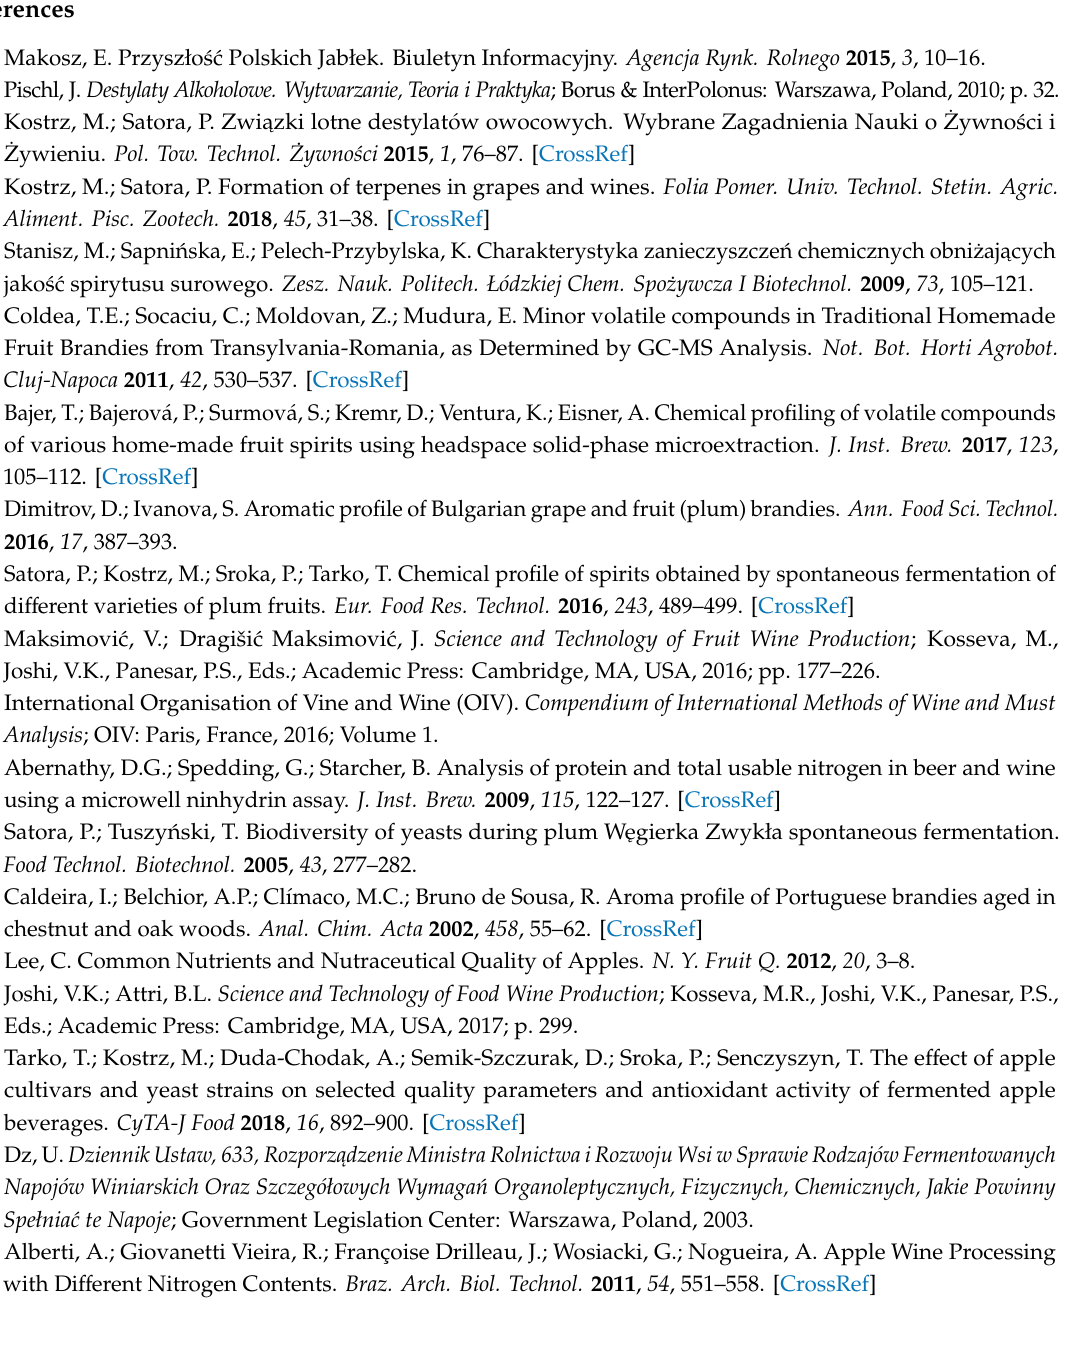
Table S1: Details regarding HPLC method for each sugar and glycerol; Table S2: Pearson correlation coe ffi cients between the intensities of the descriptors and the overall note of the brandies. Summary of statistical analyses carried out for results of sensory